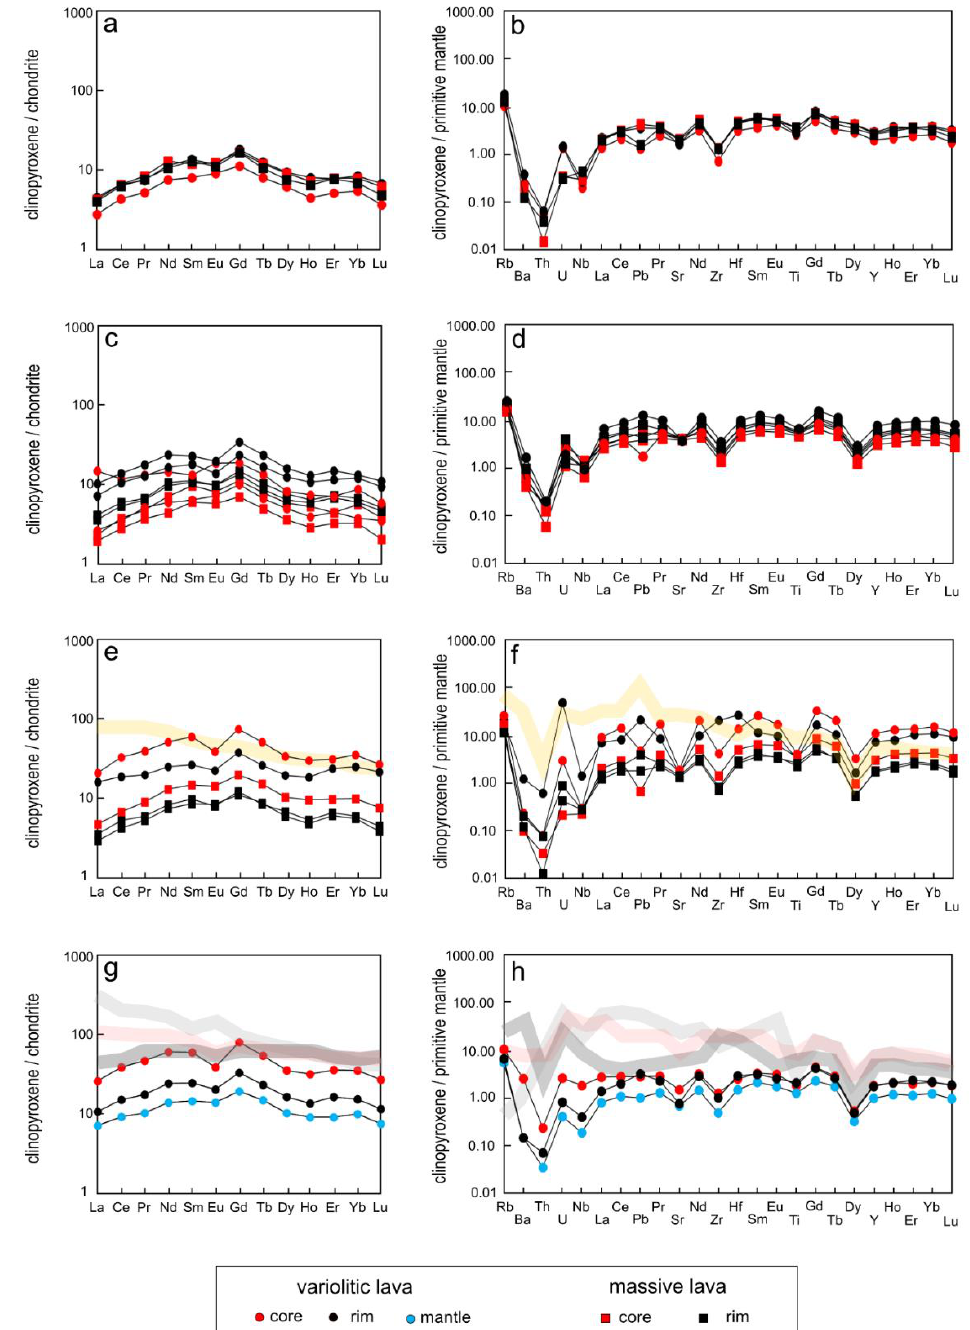
Figure 5. Chondrite-normalized REE distribution patterns and primitive mantle-normalized trace element distribution patterns for clinopyroxene phenocrysts from the variolitic and massive lavas with homogeneous patterns (HP) ( a , b ), normal zoning (NZ) ( c , d ), reverse zoning (RZ) ( e , f ), and oscillatory zoning (OZ) ( g , h ). The normalization values are from [37]. The whole-rock composition of the massive lavas (yellow colored line) is shown in e and f. The whole-rock composition of the variolitic lavas (dark grey color for matrix Type I, light grey color for matrix Type II, and rose color for the globule composition) is shown in ( g , h ) (modified from [34]).